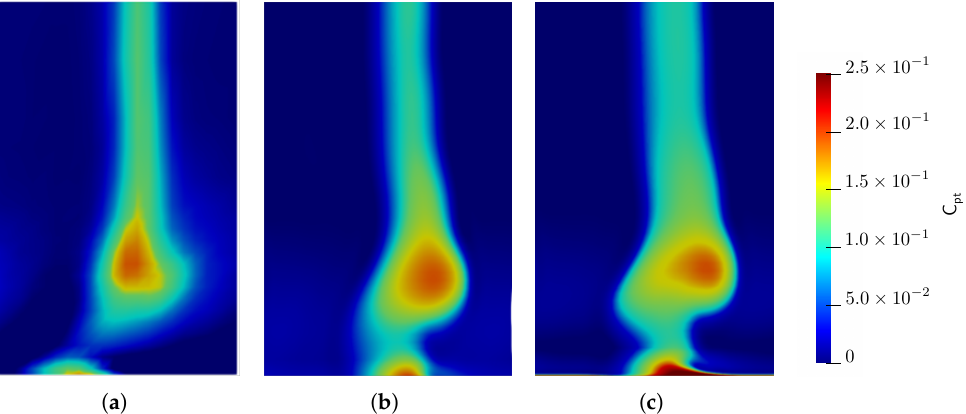
Figure 11. Contours of total pressure loss coefficient ( a ) Experimental ( b ) without GEP-EARSM ( c ) with